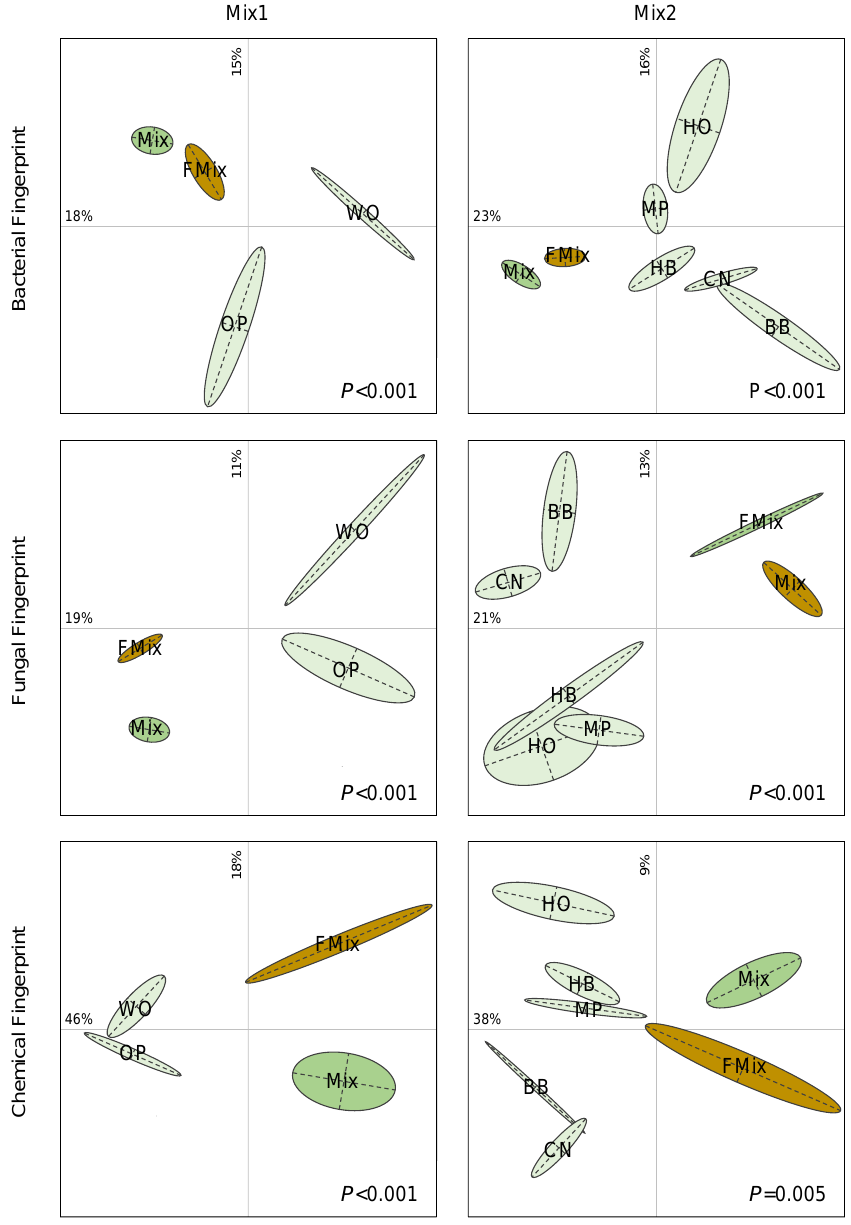
Figure 3. Differences in bacterial, fungal and chemical composition of the two mixtures of forest litters. Mix1 (WO: white oak, OP: holm oak and Aleppo pine) and Mix2 (BB: bamboo, CN: chestnut, HB: hackberry, HO: holm oak, MP: maritime pine). Mix: mixture of litters before fermentation, FMix: mixture of litters after fermentation). Between Class Analysis (BCA) is based on bacterial ( above ) or fungal ( middle ) molecular fingerprints or MIR spectra ( below ). The ellipses represent 60% of the variability of a litter. Letters represent the barycenter of the replicates (n = 3) for each treatment. Monte Carlo test simulated p values (lower right corner) revealed significant differences among